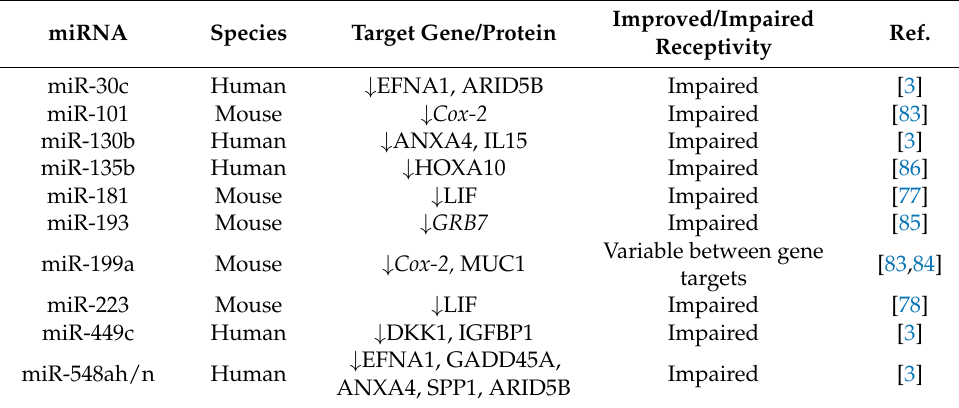
Table 1. The miRNAs identified in endometrial